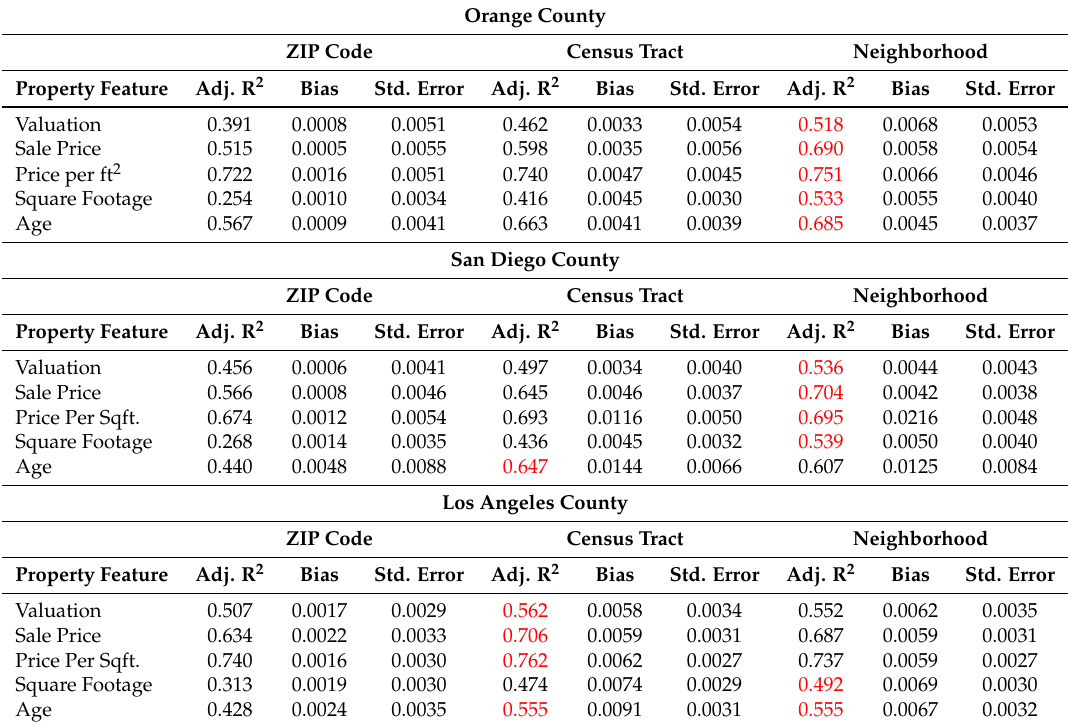
Table 3. Adjusted R squared value for each tabulation criterion, with bias and standard error computed by